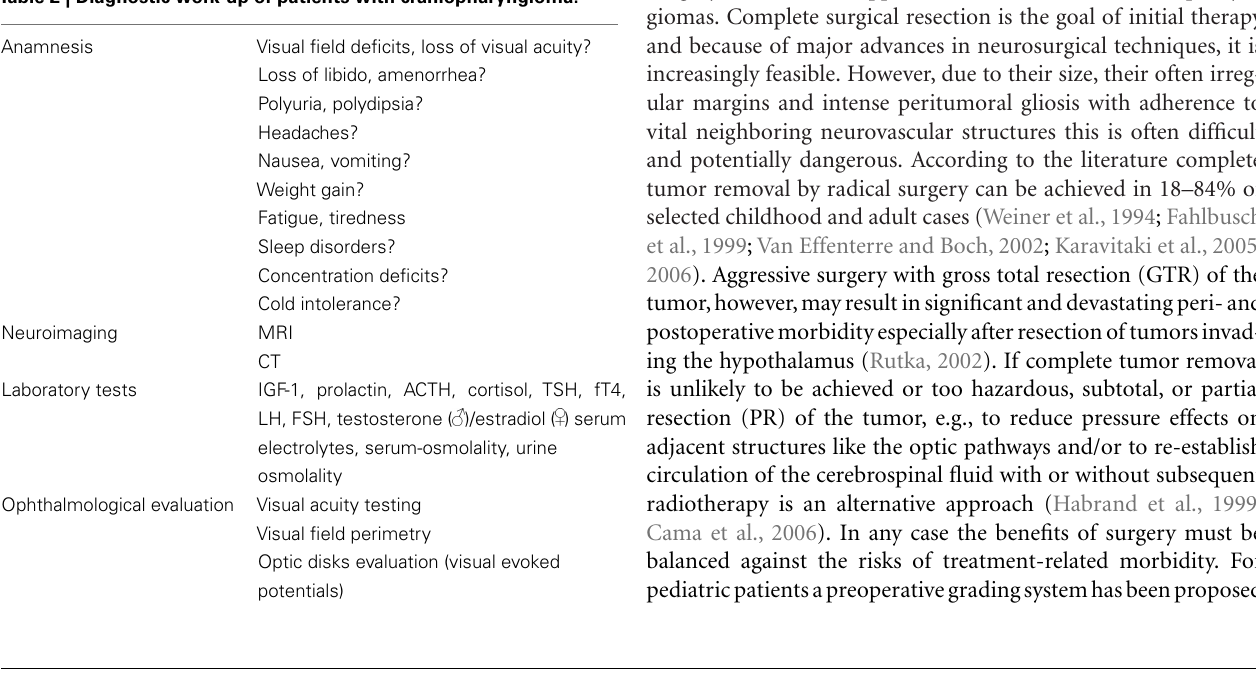
Table 2 | Diagnostic work-up of patients with